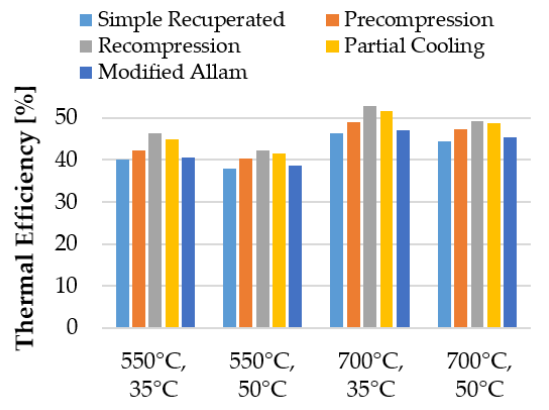
Figure 6. Thermal efficiency of the sCO 2 configurations studied, for different boundary